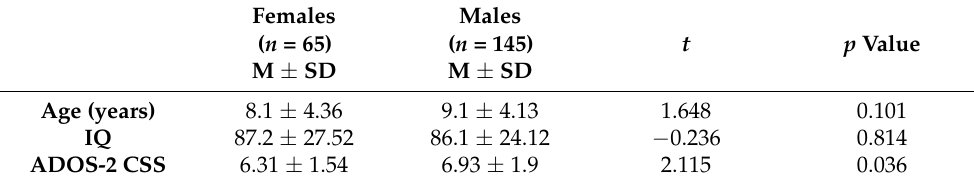
Table 1. Sex Differences in Demographic